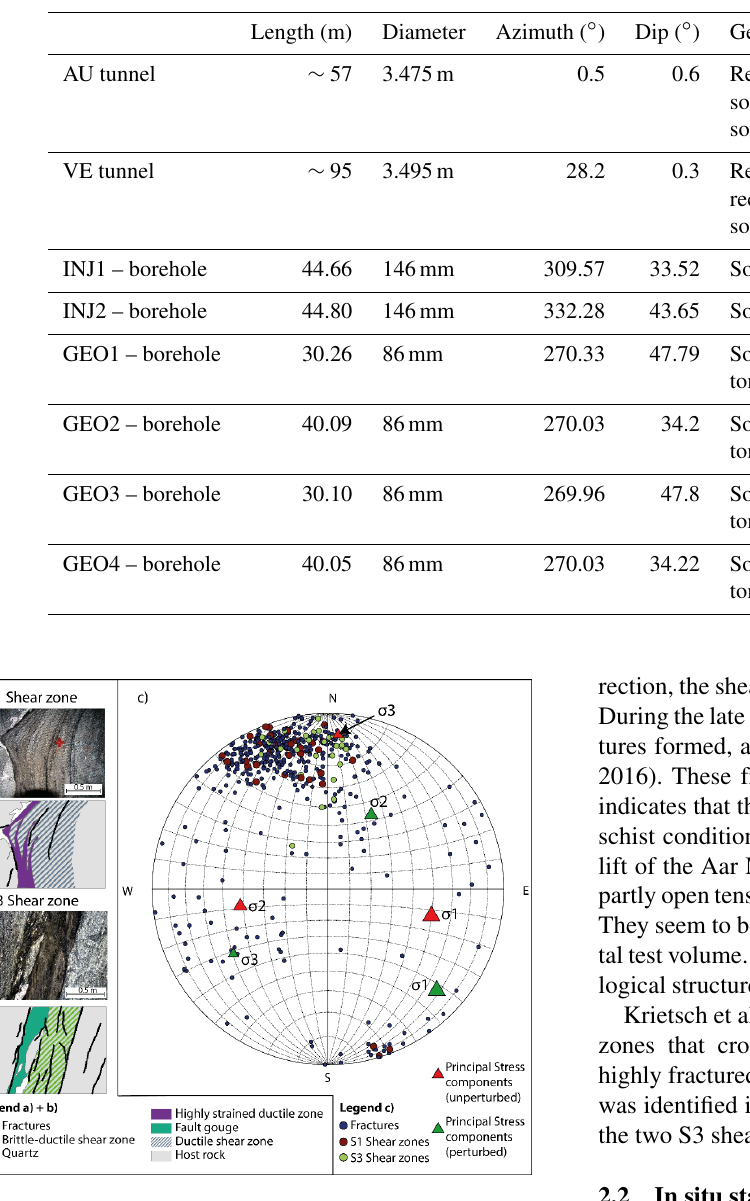
Figure 2. Overview geological structures and in situ stress field. The figure is reproduced from Krietsch et al.